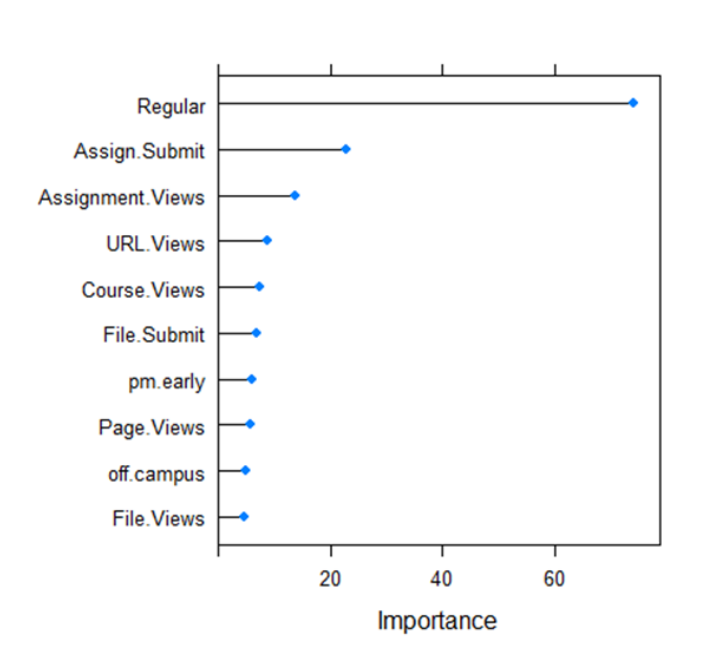
Figure 4: Variable Importance in Random Forest (Pass/Fail – All Data)